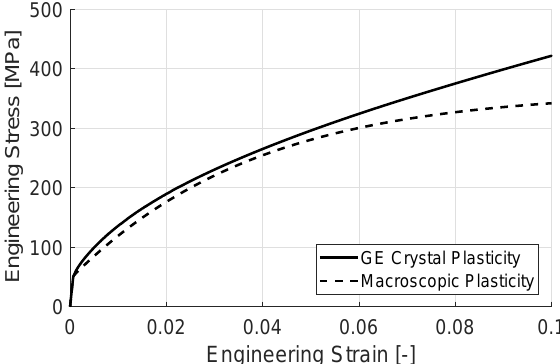
Figure 4. Numerical plane strain tension test. Fitted hardening curve of the macroscopic plasticity model to a 3D polycrystal crystal plasticity simulation including gradient effects.